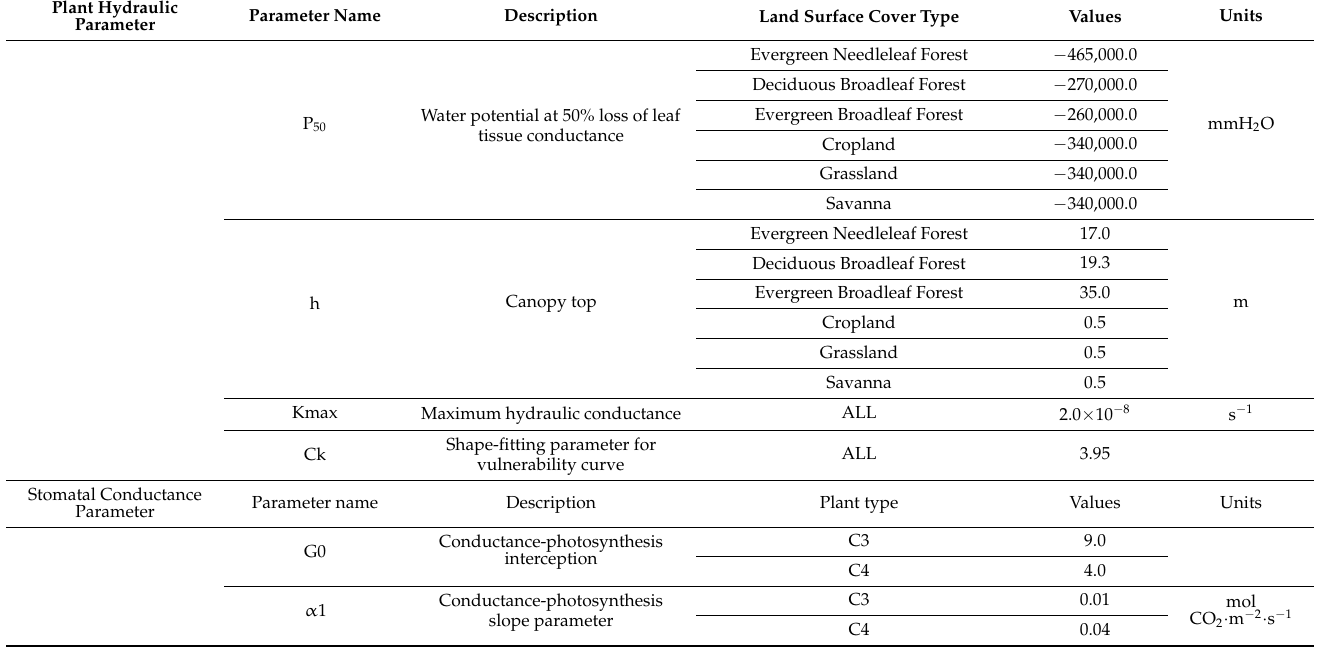
Figure A1. The flow chart of the PHS solution. Figure A1 The flow chart of the PHS solution. TableA1. The values of important parameters in PHS. Table A1. The values of important parameters in